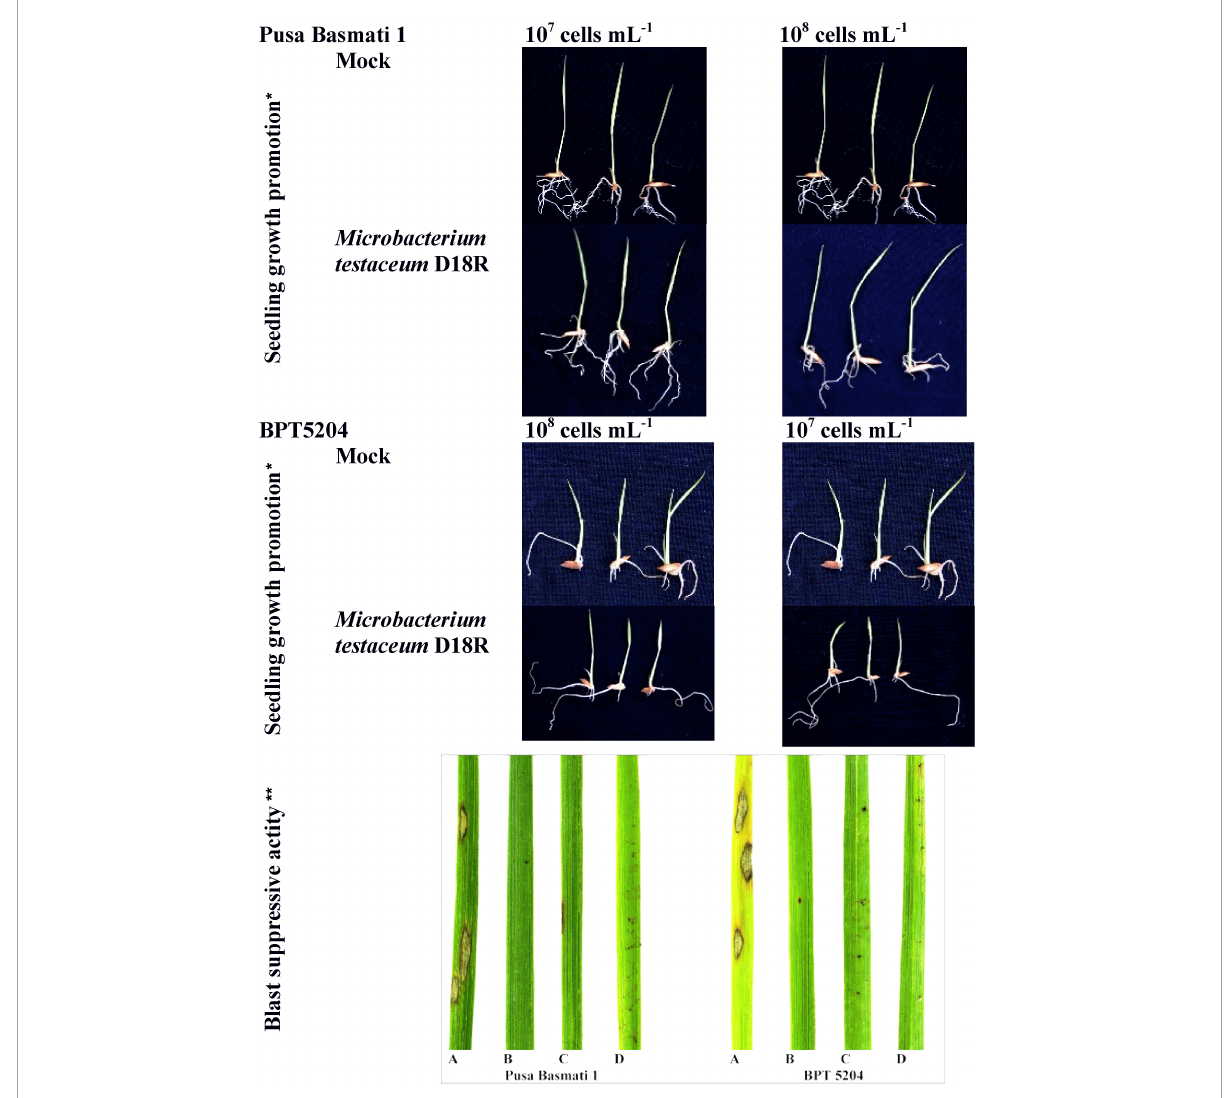
FIGURE5 Microbacterium testaceum D18 induced growth promotion in rice seedlings, and blast disease suppressive activity. *M. testaceum stimulated the growth of rice seedlings upon bacterization; **M. testaceum D18 triggered a hypersensitivity type of reaction instead of large lesions observed in mock; the hypersensitive reaction indicates over-expression of defense genes. The number of lesions and size of lesions were found reduced in bacterized plantlets; plant responses are scored as per Mackill and Bonman. (A) Mock. (B) M. testaceum D18 (10 8 CFU mL − 1 ). (C) M. testaceum D18 (10 7 CFU mL − 1 ). (D) D. Tricyclazole